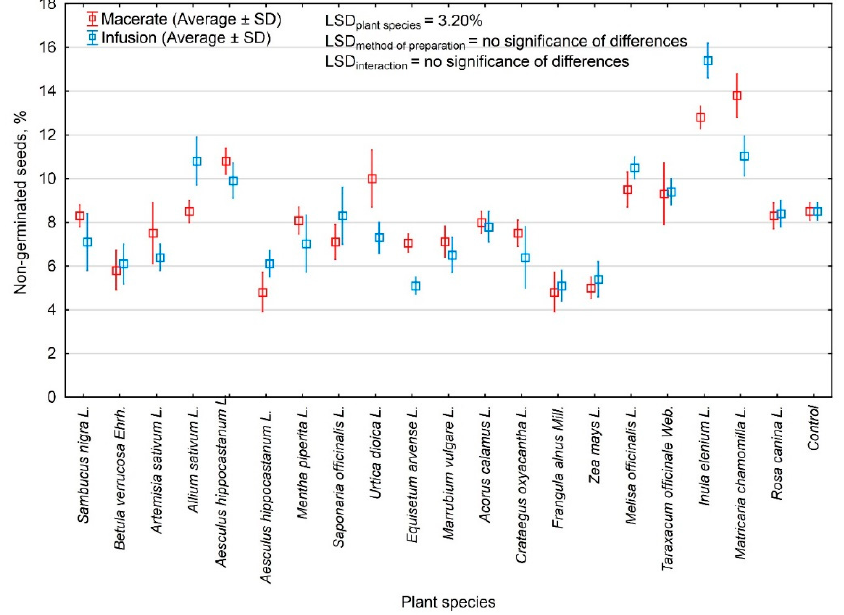
Figure 1. Nonsprouted seeds (%) depending on the plant species from which the extracts were obtained and the method of extraction. SD: standard deviation, LSD: less significant difference.